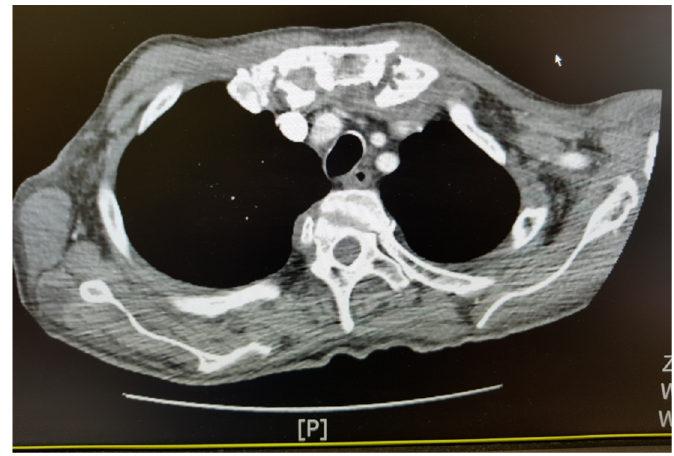
Figure 2. CT of the lungs: encapsulated fluid-containing lesions (lesion size: 26 × 17 mm and 16 × 12 mm) in the area of the subcutaneous tissue, positioned tangentially to the sternal outline of the left clavicle end—the overall image of the lesions is suggestive of abscesses; a significant degree of bilateral degenerative lesions in the area of the sternoclavicular joints; lymph nodes of the mediastinum, pulmonary hila and axillary fossa not enlarged; pleural fluid—the layer thickness up to 22 mm at the posterior wall on the left side and 17 mm on the right side; solitary, partially fibrous nodules visible in the right lung: 3 mm in diameter peripherally in 2P segment, positioned tangentially to the gap between segments 3P/6P and in seg. 6P, diameter 3 mm—post-inflammatory lesions?—for further inspection.